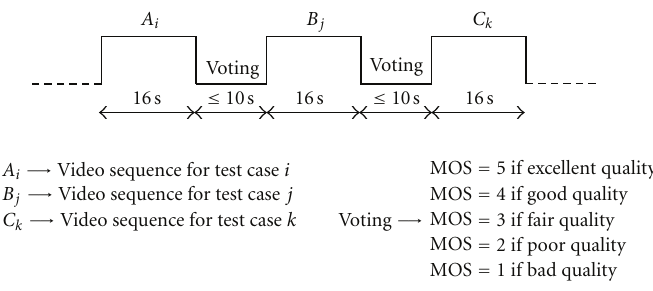
Figure 8: Stimulus presentation for ACR MOS collection as per ITU-T P.911.